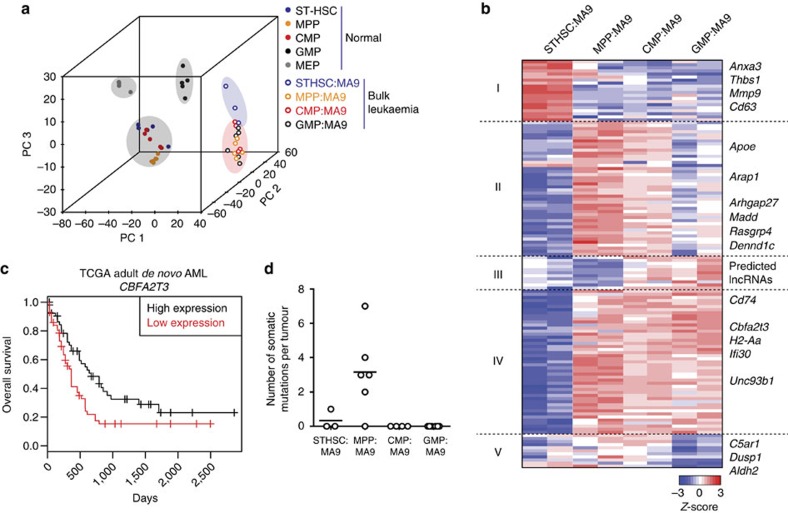
ST-HSC-derived AML has a unique and prognostically relevant gene expression signature.(a) Principal component analysis of normal and MA9-transformed haematopoietic stem and progenitor cells (STHSC; n=5, MPP; n=6, CMP; n=5, GMP; n=5, MEP; n=4, STHSC:MA9; n=3, MPP:MA9; n=6, CMP:MA9; n=4, GMP:MA9; n=6). Each sample was obtained from an individual mouse. Data were collected from two biological replicate experiments. Clustering segregates STHSC:MA9 leukemias (blue cloud) from other leukaemias (red cloud). (b) K-medioids clustering (K=5) of 133 differentially expressed genes in leukaemias based on cell of origin (foldchange >2, FDR<0.05) (STHSC:MA9; n=3, MPP:MA9; n=6, CMP:MA9; n=4, GMP:MA9; n=6). Representative biological replicates are shown. (c) Overall survival of human AML patients based on expression of CBFA2T3 (n=200). Log-rank test; P=0.0113. (d) Number of somatic nucleotide variants (SNVs) per tumour derived from distinct cells of origin (STHSC:MA9; n=3, MPP:MA9; n=6, CMP:MA9; n=4, GMP:MA9; n=6). Each sample was obtained from an individual mouse. Data were collected from two biological replicate experiments. Kruskal–Wallis test; P=0.0019.